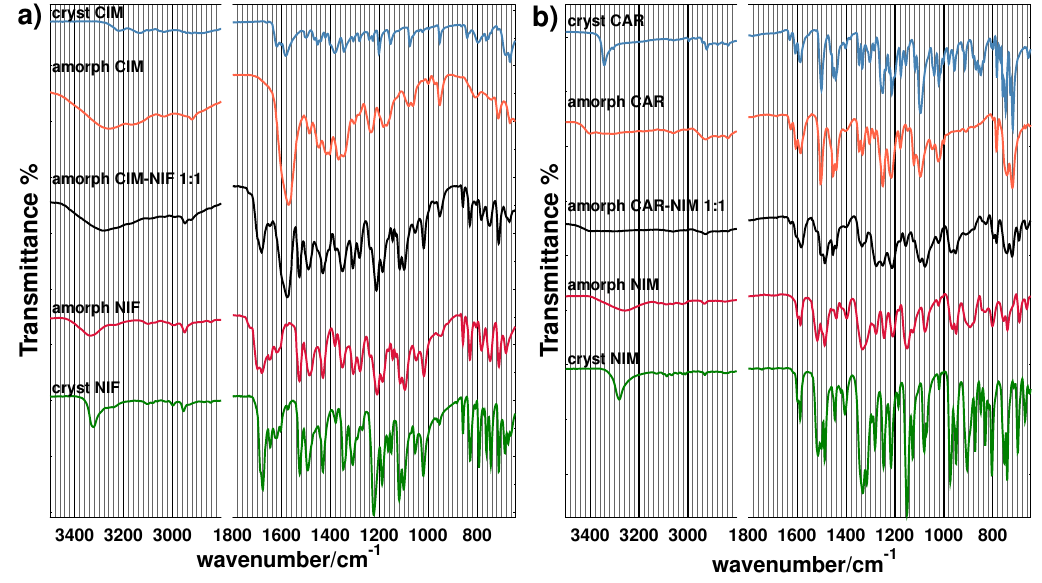
Figure 9. Fourier transform infrared (FTIR) spectra for crystalline and amorphous samples of pure active ingredients and amorphous 1:1 mixture for the systems ( a ) cimetidine–nifedipine and ( b )